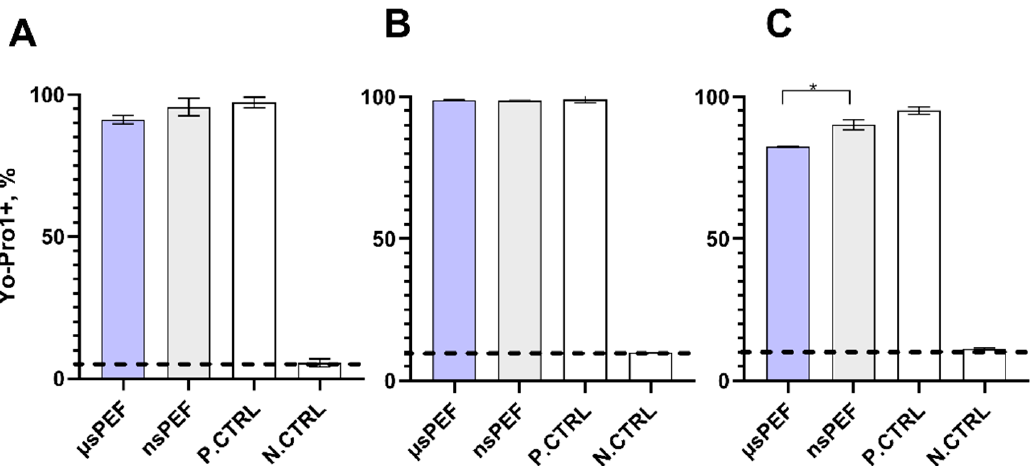
Figure 2. Cell permeabilization using µsPEF (1.2 kV/cm x 100 µs × 8 pulses) and nsPEF (7 kV/cm × 300 ns × 100 pulses (1 MHz)): CHO-K1 ( A ), 4T1 ( B ), and DCs ( C ). Positive control (P. CTRL)—(1.5 kV/cm × 100 µs × 8 pulses); negative control (N. CTRL)—nontreated cells. Asterisk (*) corresponds to statistically significant ( p < 0.05) difference.